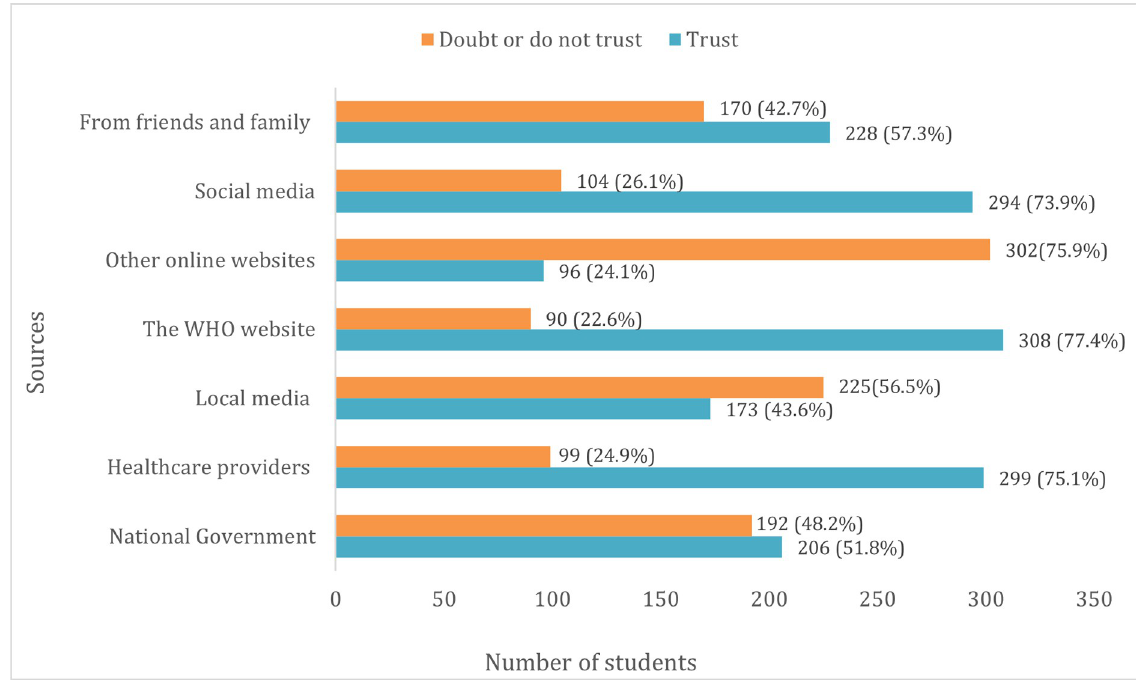
Fig 4. Students’ trust on sources of COVID-19 information.